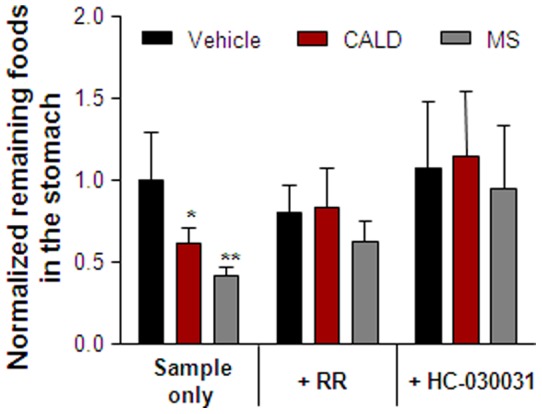
Effect of cinnamaldehyde (CALD) and methyl syringate (MS) on food remaining in the stomach.Vehicle (1.5% methyl cellulose), CALD, or MS were administered orally to ICR mice at a dose of 10 mg/kg after fasting in the presence or absence of the TRPA1 antagonists, ruthenium red (RR) and HC-030031. After 28 h, mice were sacrificed and the stomach contents of each were weighed. Columns and vertical bars represent means ± SEM (n = 4); *p<0.05 compared with the vehicle control.